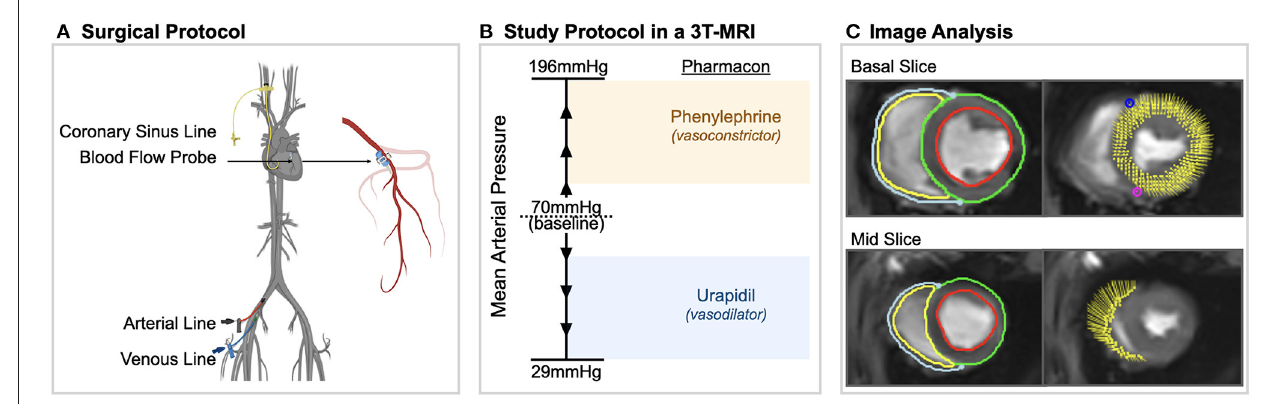
FIGURE 1 | Experimental procedures. (A) Surgical procedures included placement of arterial, venous and coronary sinus lines and a blood flow probe on the left anterior descending coronary artery in anesthetized swine. (B) In a 3 tesla (T) magnetic resonance imaging (MRI) machine, mean arterial blood pressure was varied in steps of 10–15 mmHg from 29 to 196 mmHg using phenylephrine and urapidil. At each level, oxygenation-sensitive (OS) cine images along with invasive measurements were acquired. (C) Using CMR feature tracking-software, left and right ventricular systolic and diastolic strain measurements were obtained from the same cine images in which myocardial oxygenation was